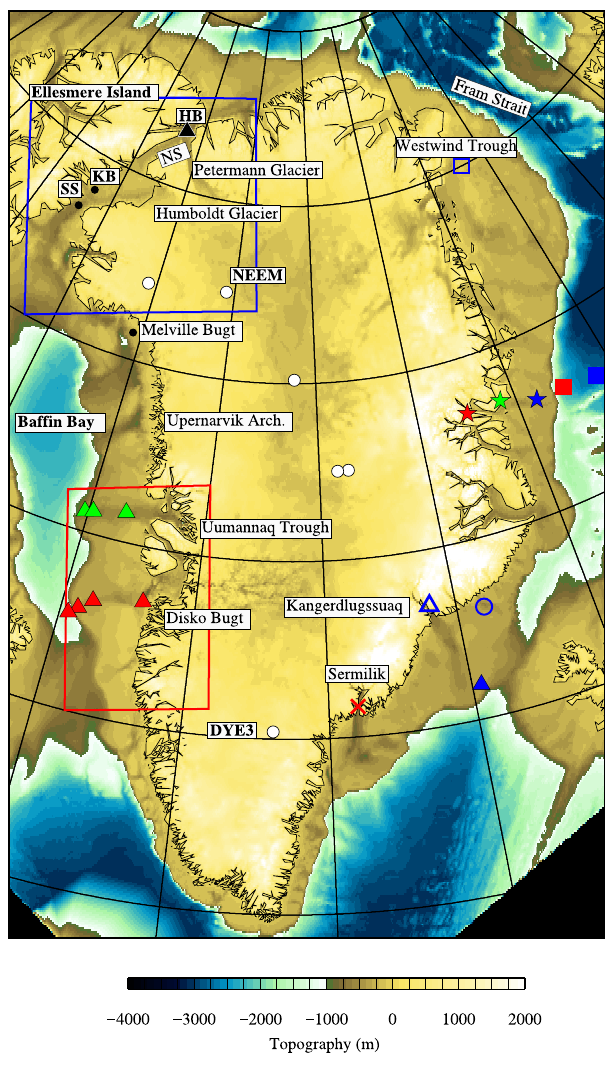
Figure 1. Summary of the place names and regions referred to in the main text and locations of observational data. All information describing the symbols and references for the observational data is listed in Table 1. The red and blue boxes highlight the regions shown in Figs. 7 and 8,